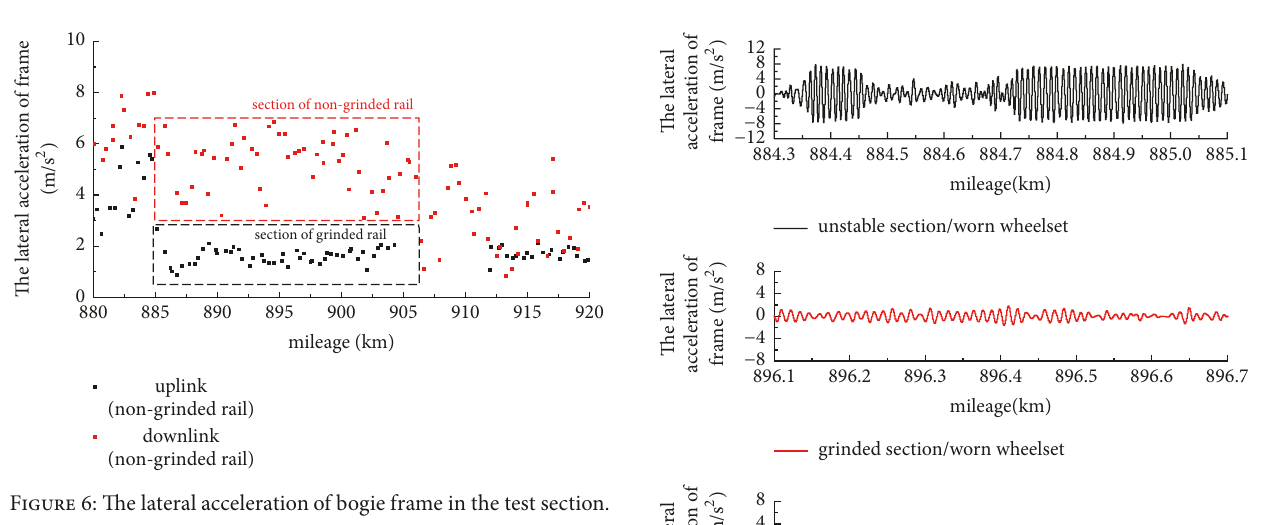
Figure 5: The alarm sensor and detection instability host.